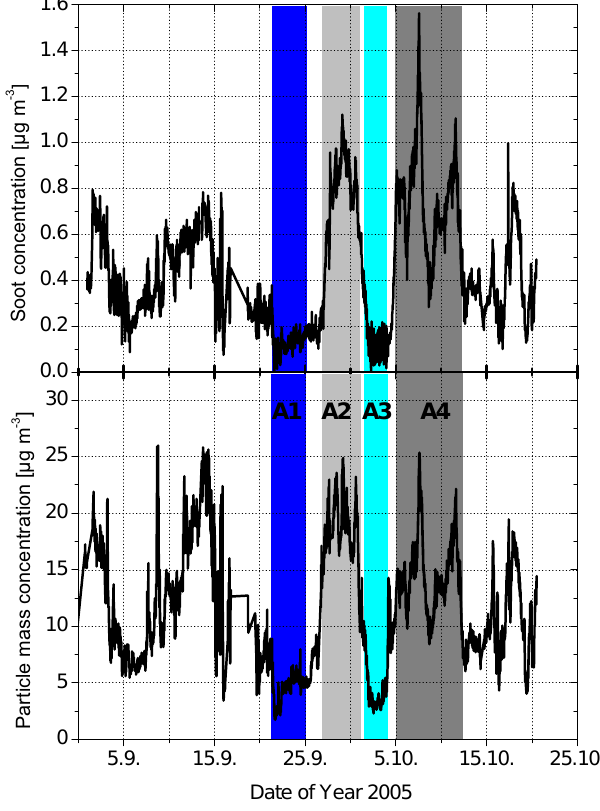
Fig. 4. Soot mass concentration measured by the MAAP instru- ment, and total particle mass concentration derived from DMPS and APS measurements. A1–A4 indicate four selected time periods rep- resenting rather distinct air mass types.